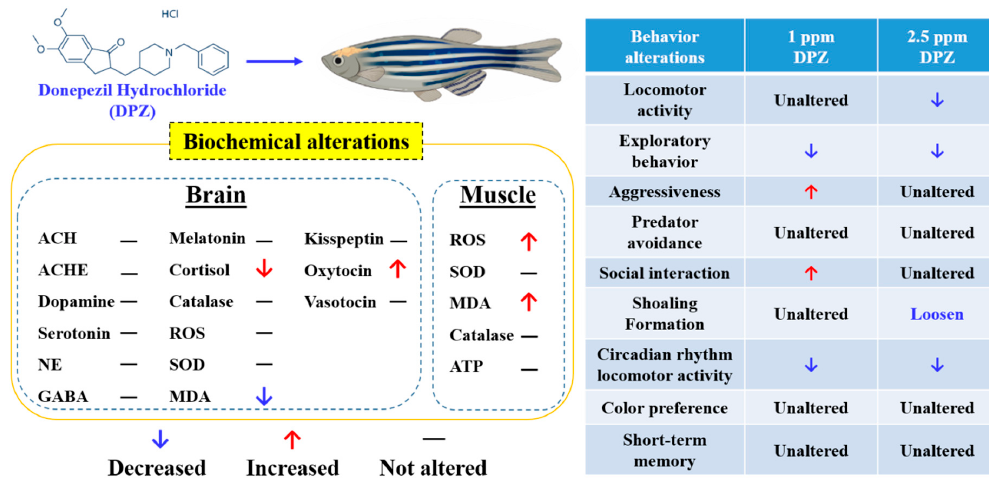
Figure 8. Summary of biochemical and behavioral changes in adult zebrafish after acute or chronic exposure to Donepezil. The behavioral alterations are summarized in the right panel and the biochemical alterations in brain and muscle tissues are summarized in the left panel.